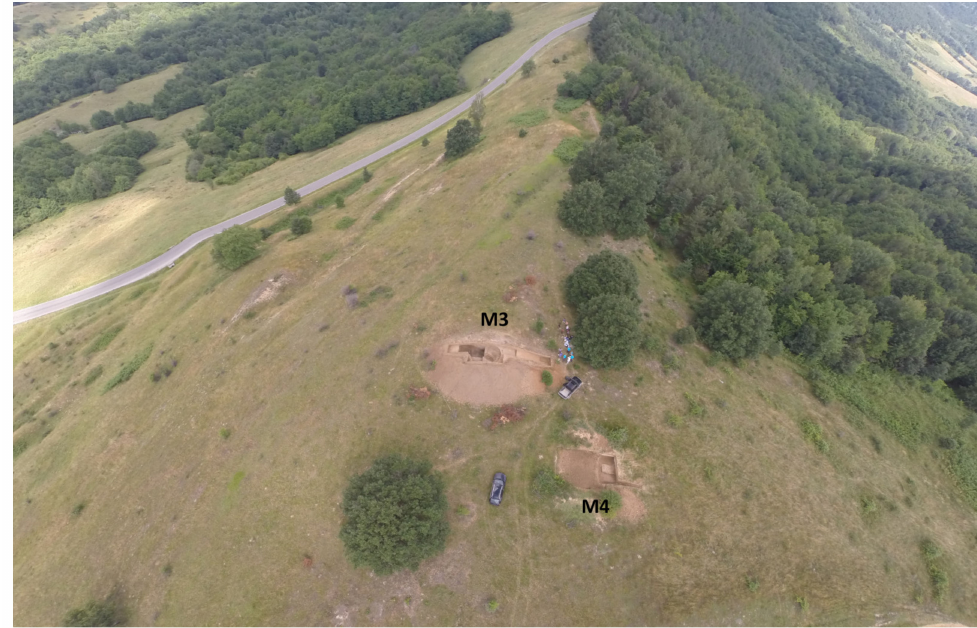
Figure 3. Drone photography of M3 and M4 excavation (Photo credit: InfoHD).